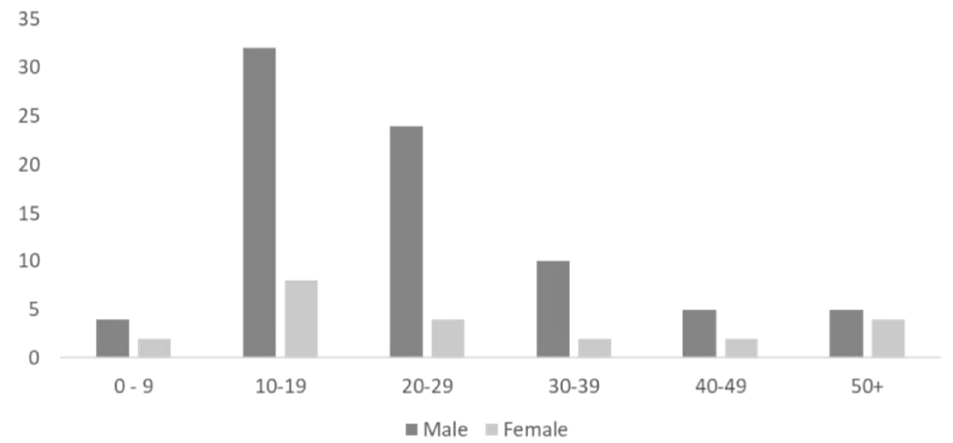
Figure 9. Percentage of A&E attendances for sport injuries by age group; data adapted from Nhs.uk [93].